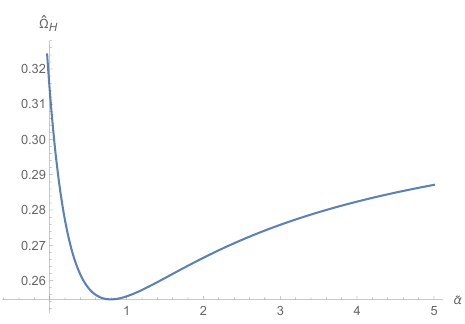
Figure 1 . Dependence of the reduced horizon angular velocity ^(cid:10) H of the EGB black ring on the GB coe(cid:14)cient ~ (cid:11) with R =